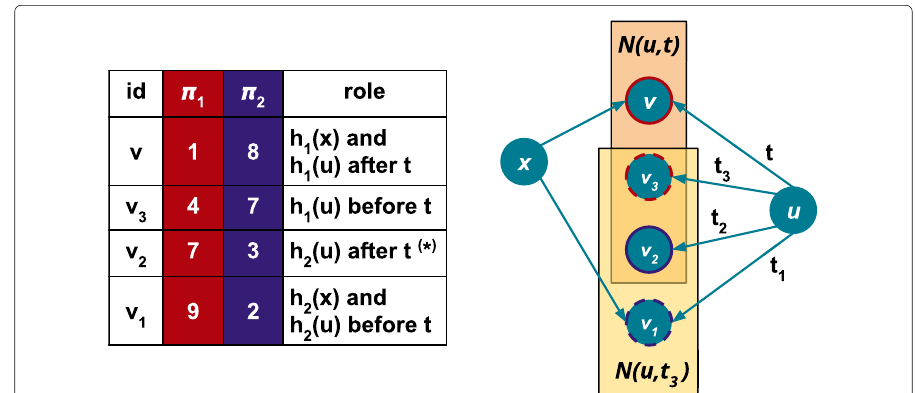
Fig. 7 Illustration of how the fingerprints of node u change when adding the new edge uv . Neighbors of u are ordered in time as t 1 < t 2 < t 3 < t . Two fixed random permutations π 1 and π 2 define the fingerprints h 1 ( u ) and h 2 ( u ) . In π 1 (red), v has minimum value, hence the previous h 1 ( u ) will be reassigned to v . In π